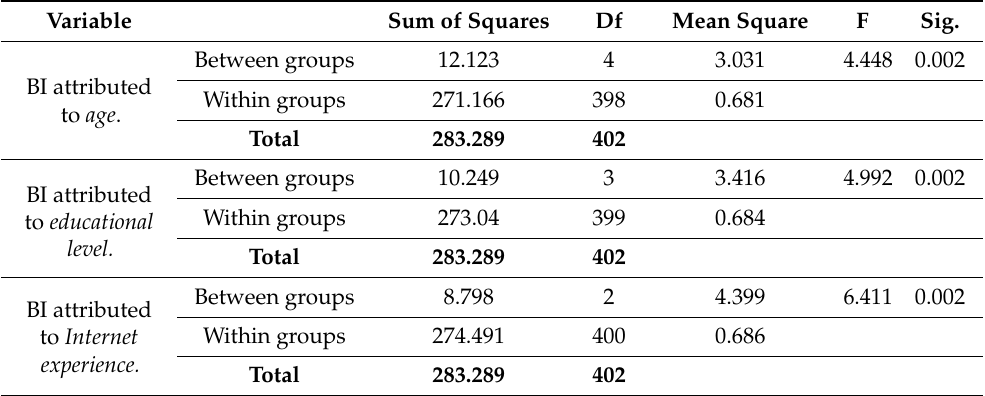
Table 9. ANOVA Analysis of respondents’ BI attributed to age, educational level, and Internet experience.